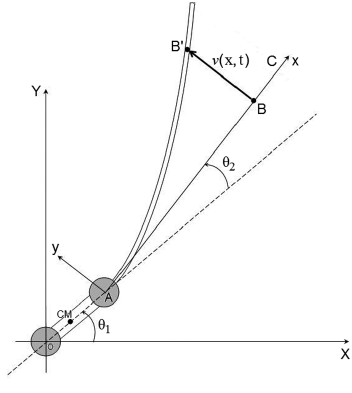
Fig. 1. The slewing flexible beam